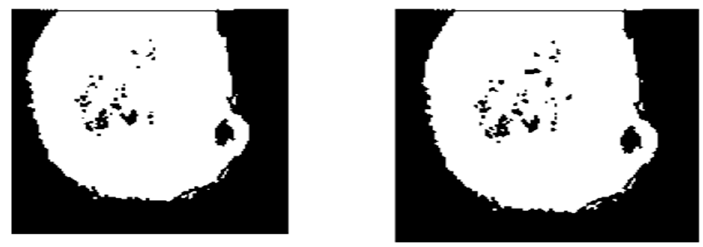
Figure 5. PSO clustering ( left ), and PBPSO clustering ( right ).